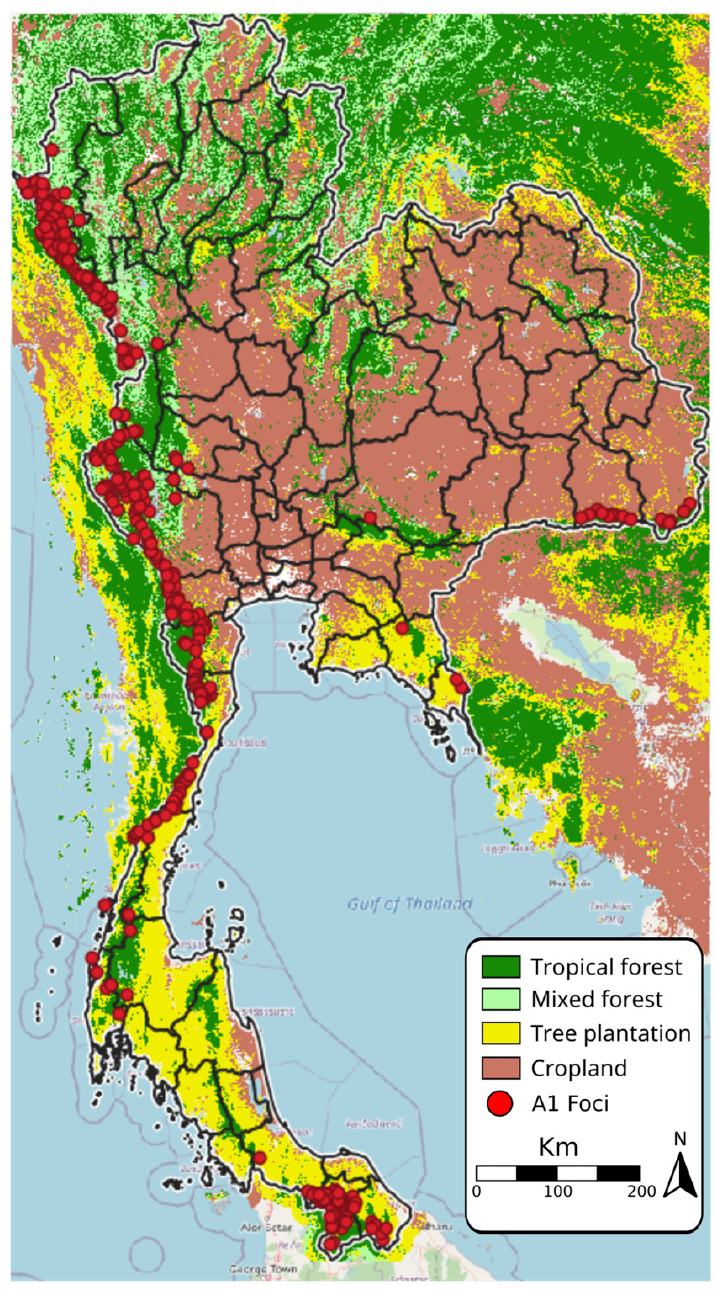
Figure 3. Areas covered by forest, plantation, and cropland with A1 foci, FY2020. The areas surrounding A1 foci at the borders with Myanmar (A, C), Cambodia (B), and Malaysia (D) are magnified in Figure 4. There is heterogeneity in the habitats sur ‐ rounding active foci. In the Mae Hong Son and Tak provinces in the northwest of Thailand (2A), active foci are surrounded by forest; however, on the Myanmar side of the border, the environment is a mix of forest with plantation. In the other hotspot areas, plantations are notable, and they are usually close to forests. Plantations are also the dominant habi ‐ tats surrounding A1 foci close to the border with Malaysia (D).